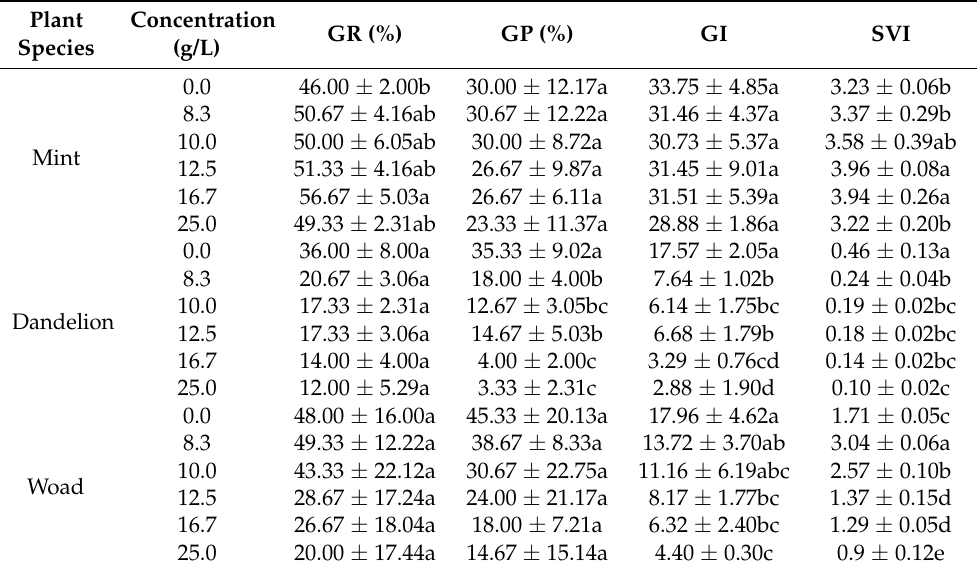
Table 1. Effect of different concentrations of the aqueous leaf extract of fig tree on the seed germination of mint, dandelion, and